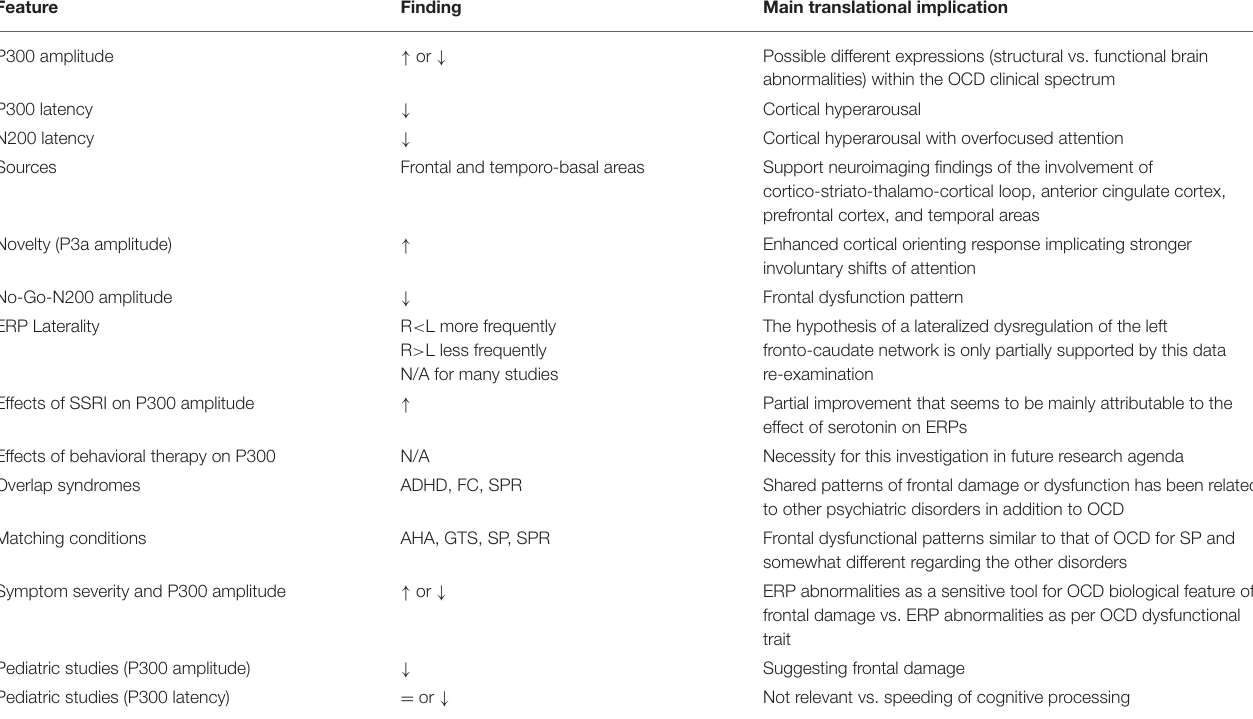
TABLE 2 | Summary of the relevant data found in obsessive-compulsive disorder regarding the event-related potential components considered in this review.